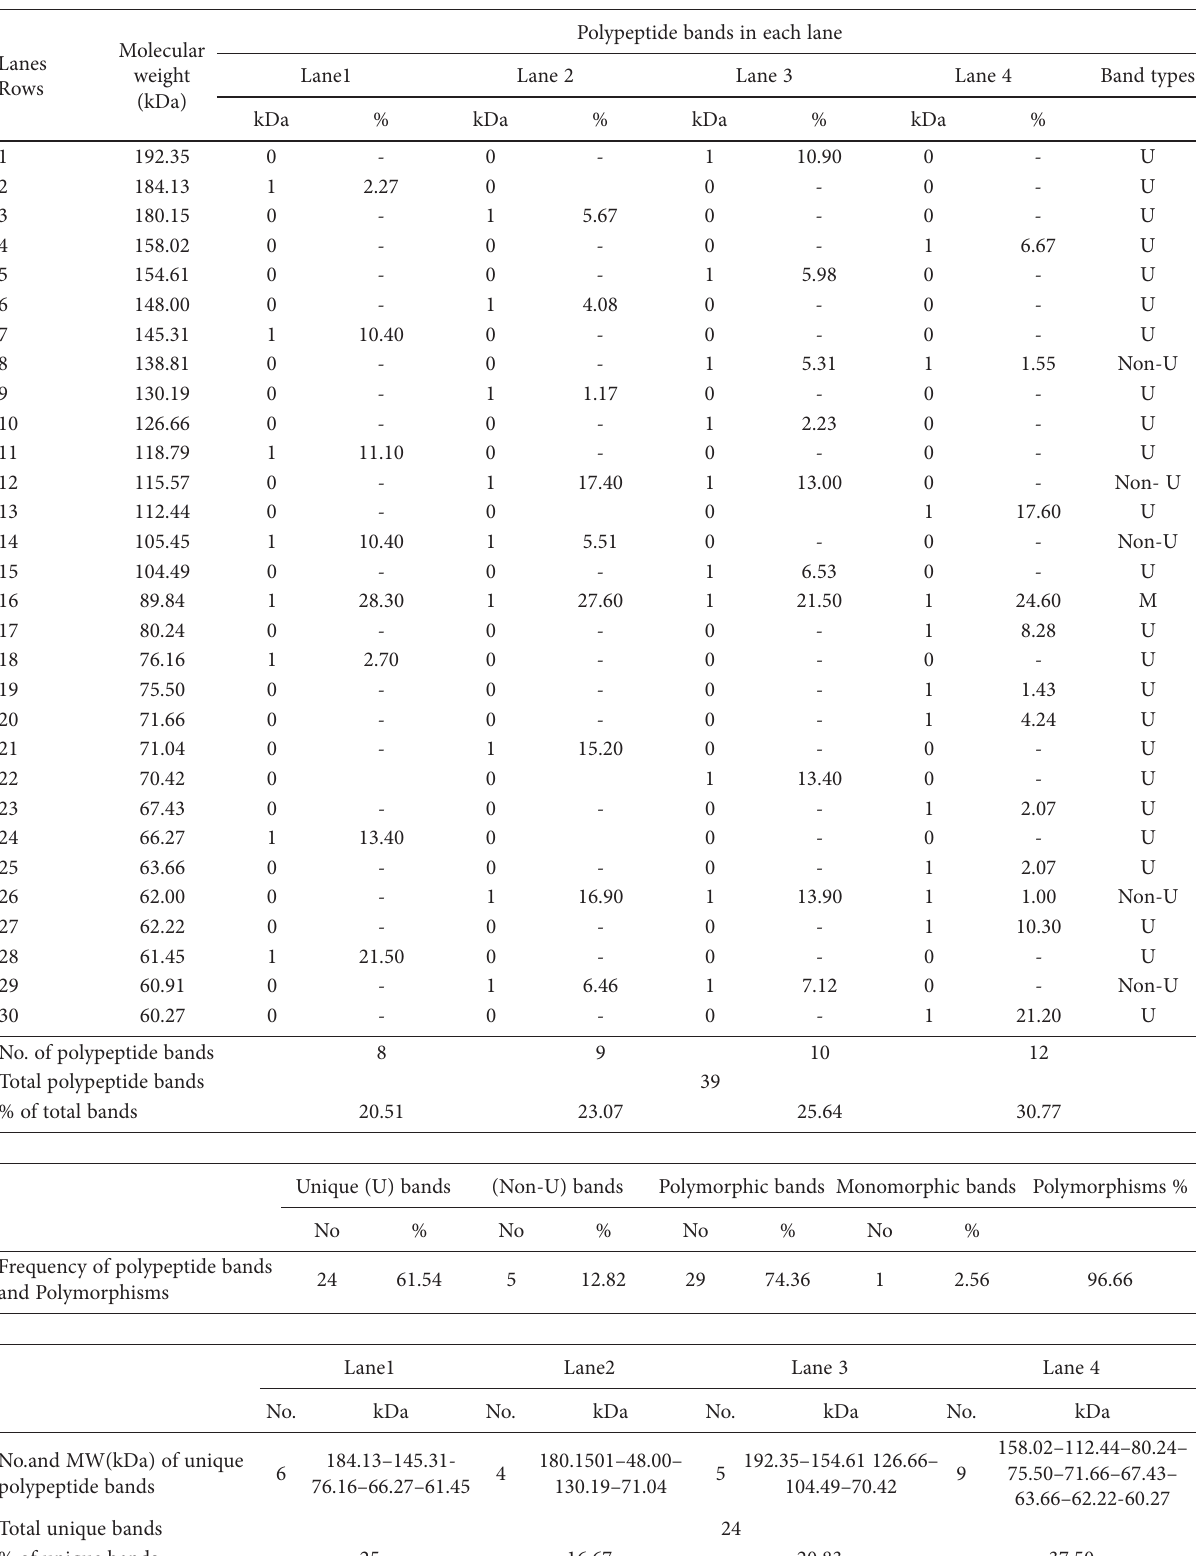
Table 1. Sodium dodecyl sulfate-polyacrylamide gel electrophoresis (SDS-PAGE) analysis of proteins of EMF exposed and non-exposed Zea mays seedlings for days of exposure times (Ex-0, Ex-1, Ex-3,and Ex-5) using the documentation system Gel Doc Bio Rad system 2000. Lanes 1–4 represented the days of exposure times (Ex-0, Ex-1, Ex-3,and Ex-5),